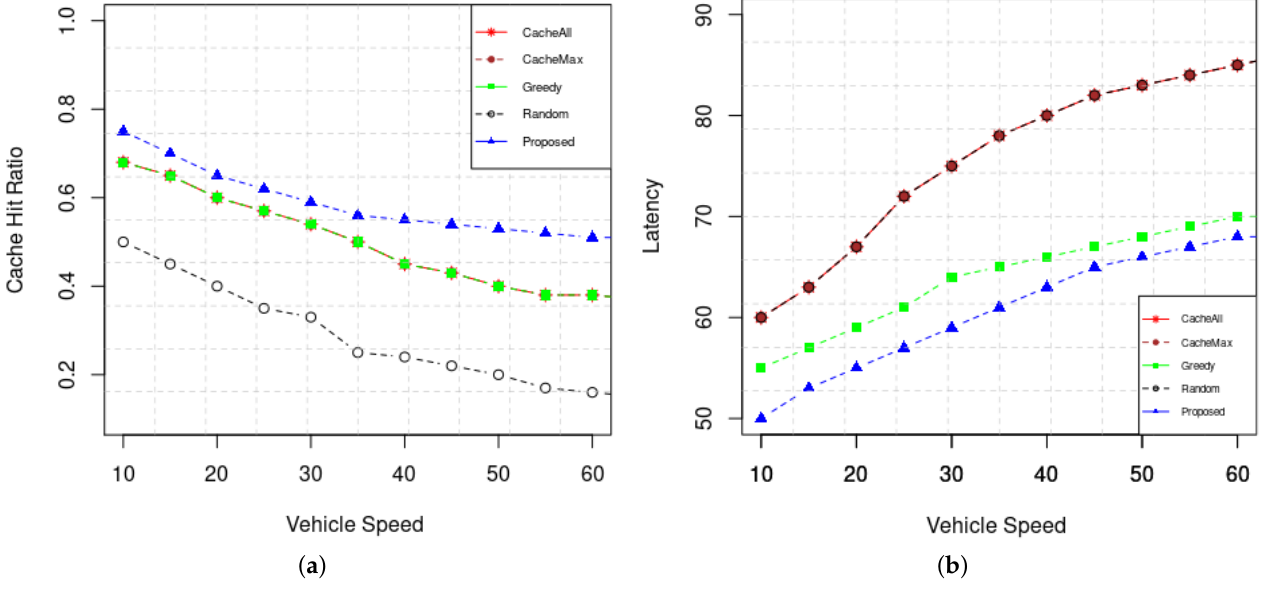
Figure 9. Analysis of Mobility impact ( a ) Cache hit ratio. ( b )